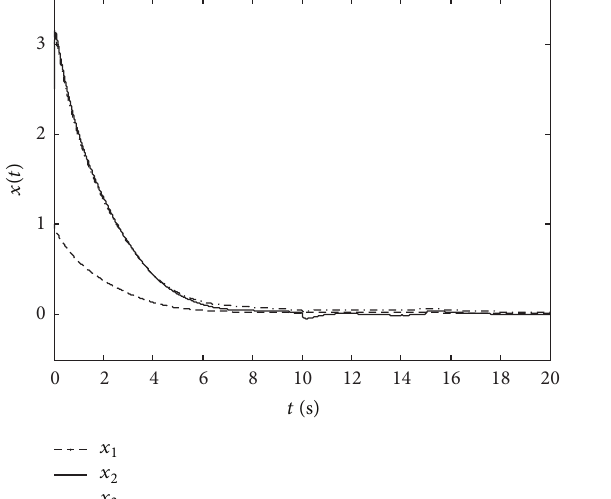
Figure2:Thecurveof 𝑥(𝑡) withtheproposedcontrolscheme((29a), (29b), and (29c)).